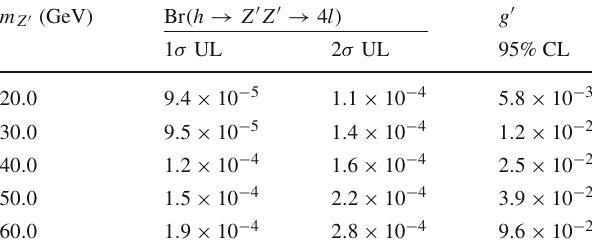
Table 2 Upper limit on the branching ratios of the Higgs boson decays into Z (cid:2) Z (cid:2) followed by Z (cid:2) → l ¯ l and the gauge coupling constant g (cid:2) . Numbers of the branching ratio and the gauge coupling are taken from Figure 10.(a) of [51] and Figure 8 of [52], respectively